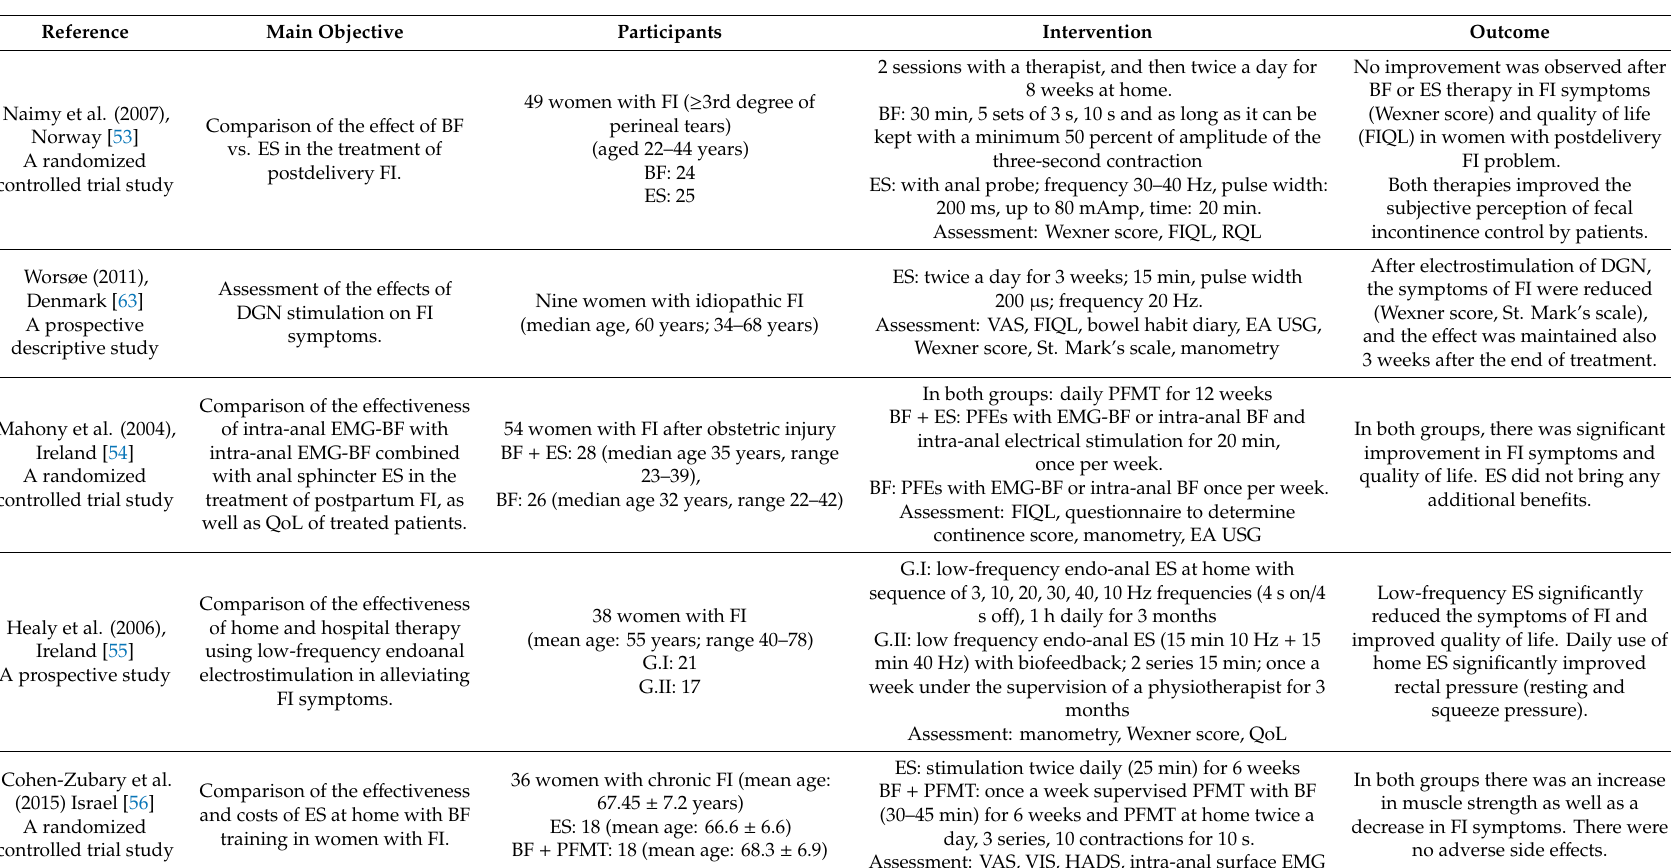
Table 7. Characterization of selected studies on the e ff ects of electrostimulation (ES) on the severity of fecal incontinence